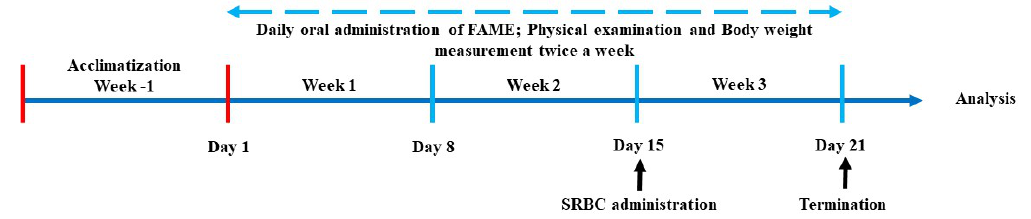
Figure 2. Outline of the in vivo